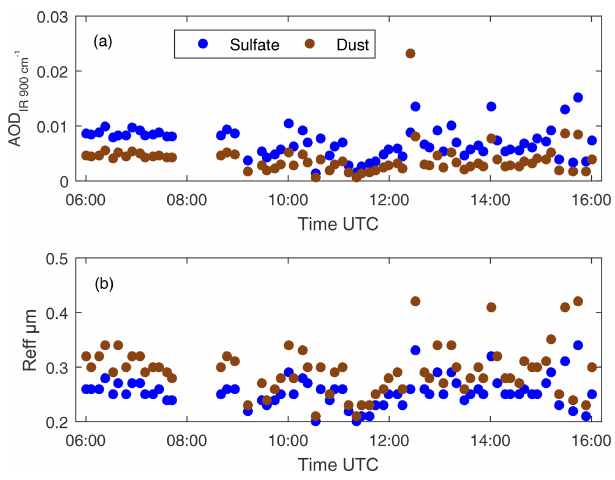
Figure 7. (a) The AOD of sulfate (blue) and dust (brown) retrieved from emission FTS measurements and (b) R eff results with same color information on 10 June